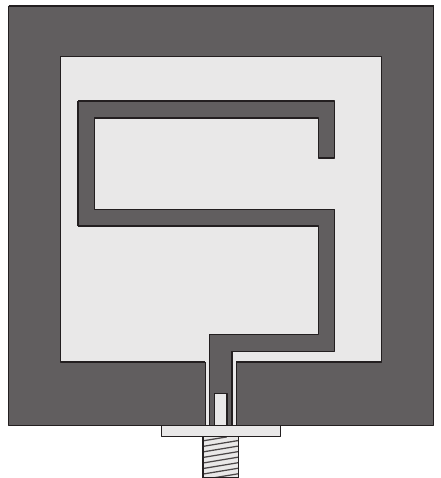
Figure18:Adual-bandcircularlypolarizedrectangularslotantenna with an S-shaped monopole [85]. The excitation of edge currents together with those excited on the monopole is suitable to support a circular polarization. Dark gray upper metal face and light gray dielectric